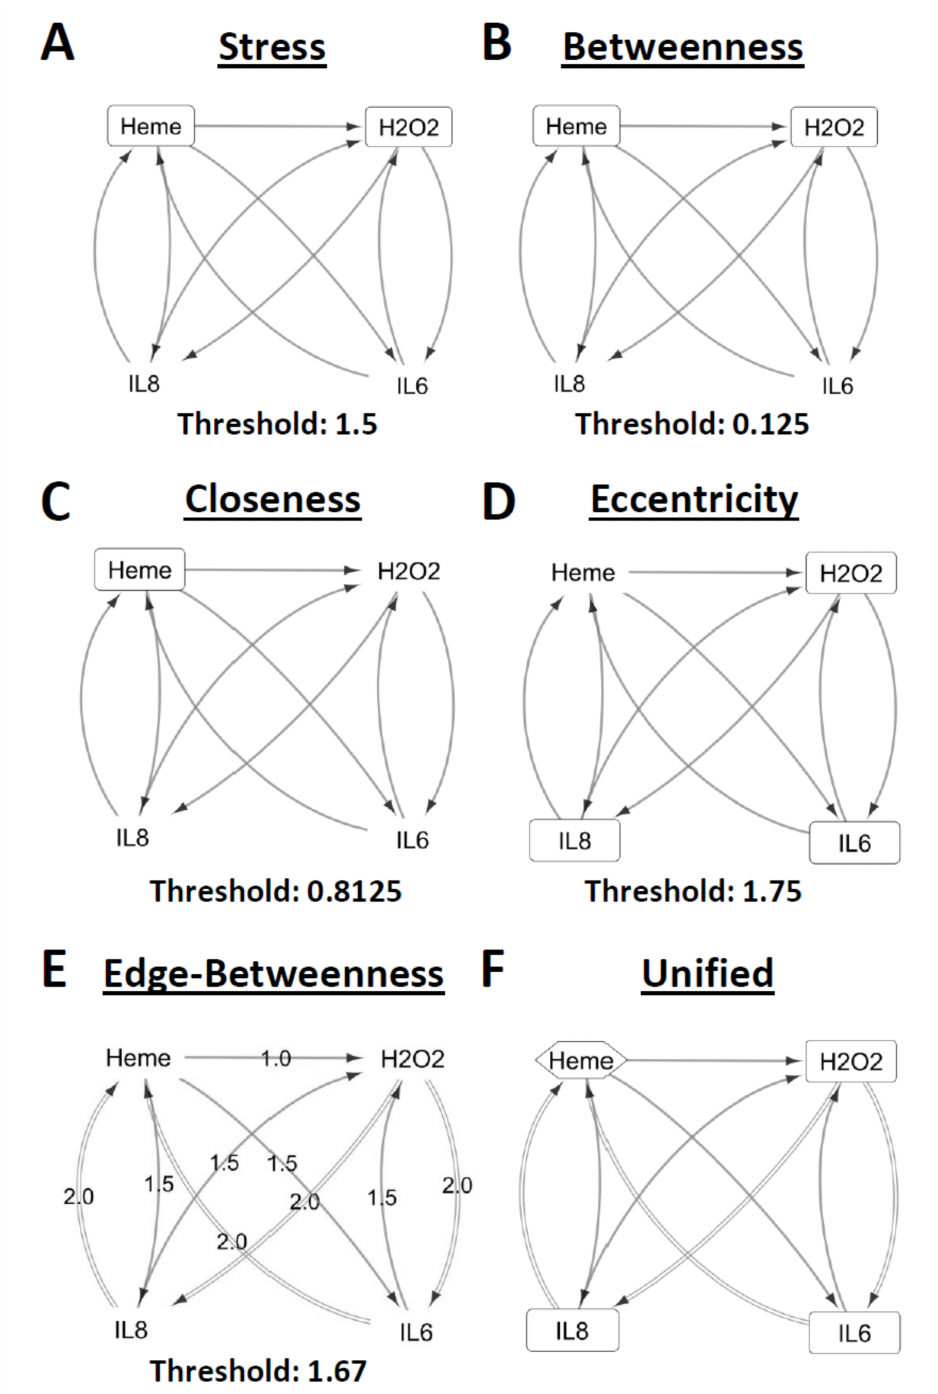
Figure3. Networkdesignandanalysisofsecretedinflammatory-andstress-relatedsignalsfromprimary human respiratory epithelial cells incubated with either heat-killed Fusobacterium nucleatum. ( A ) stress, ( B ) betweenness, ( C ) closeness, ( D ) eccentricity, and ( E ) edge-betweenness centrality measurements are shown. Threshold for each centrality measurement is indicated below the respective network design. Nodes determined to be above the threshold are indicated in a rectangular box. Edges established to be above the threshold are indicated as double-lined arrows. ( F ) Unified network combines the significant nodes and edges from all centrality measurements. The node considered to important, crucial, and relevant to the network is indicated in a hexagonal box. Nodes that are easily accessed is indicated in a rectangular